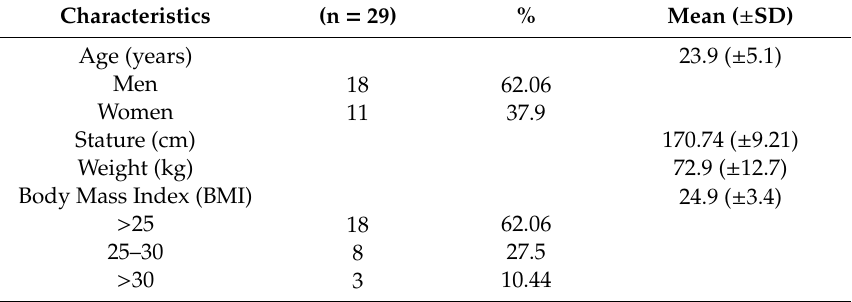
Table 2. Subject